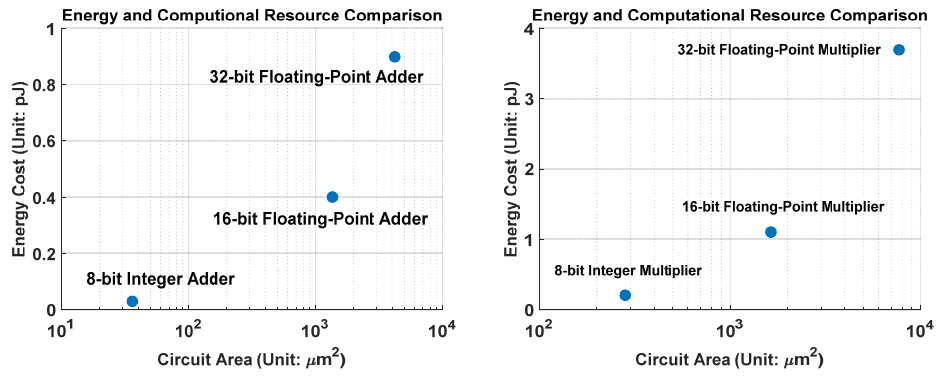
Figure 2. Energy saving vs. hardware resource reduction.